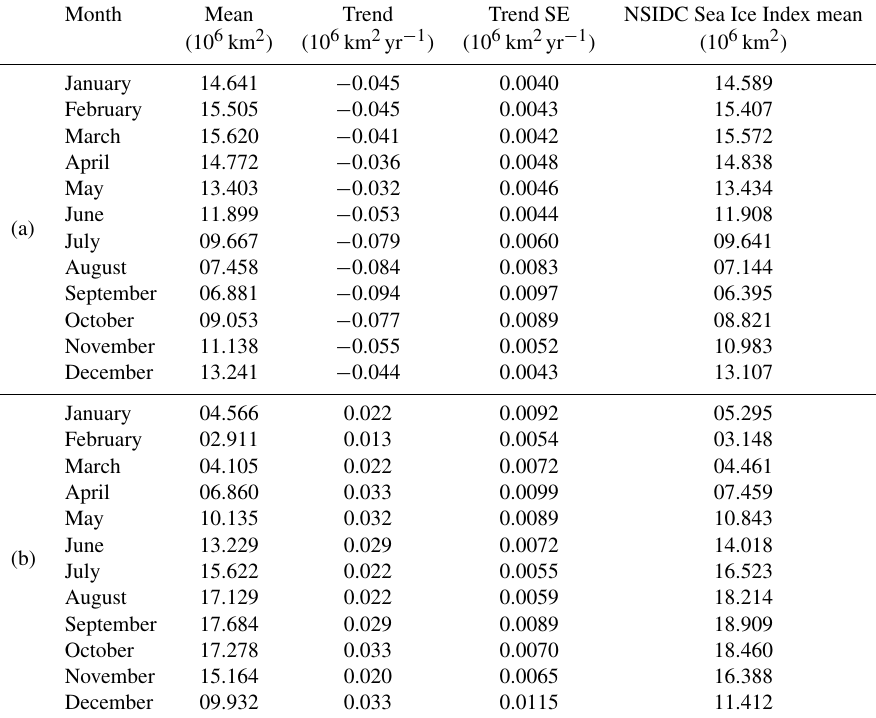
Table 3. (a) The mean monthly sea ice extent 1978–2014, long-term trend, and standard error of the trend in the Arctic. All figures are in millions of square kilometre. The right-hand column shows the mean monthly NSIDC Sea Ice Index Arctic sea ice extent (1978–2014) for comparison (Fetterer et al., 2016). (b) The mean monthly sea ice extent 1978–2014, trend, and standard error of the trend in the Antarctic. All figures are in millions of square kilometre. The right-hand column shows the mean monthly NSIDC Sea Ice Index Antarctic sea ice extent (1978–2014) for comparison (Fetterer et al.,